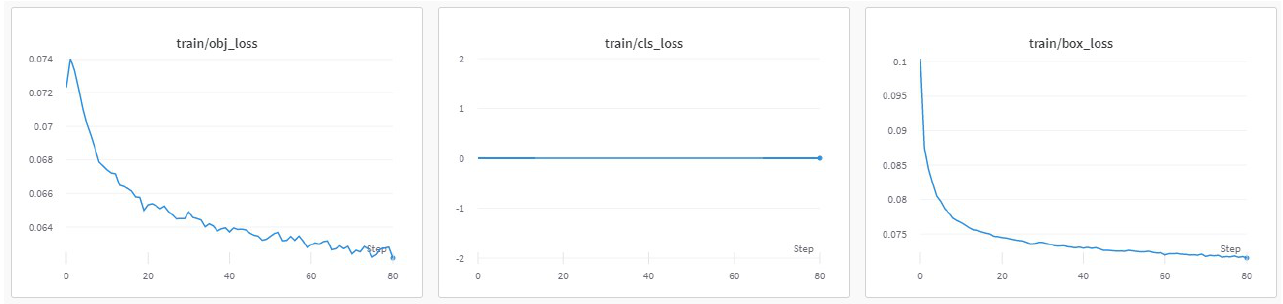
Figure 9. Basic training metrics of the custom model.